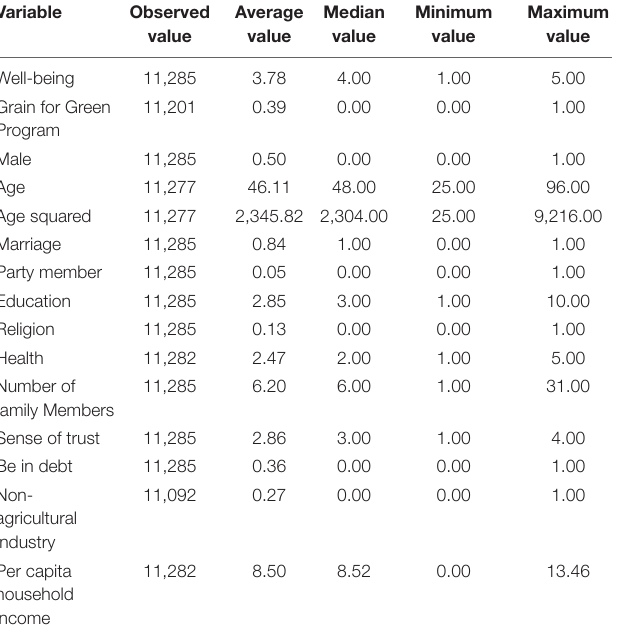
TABLE 1 | Descriptive statistics. TABLE 2 | Benchmark regression results: life